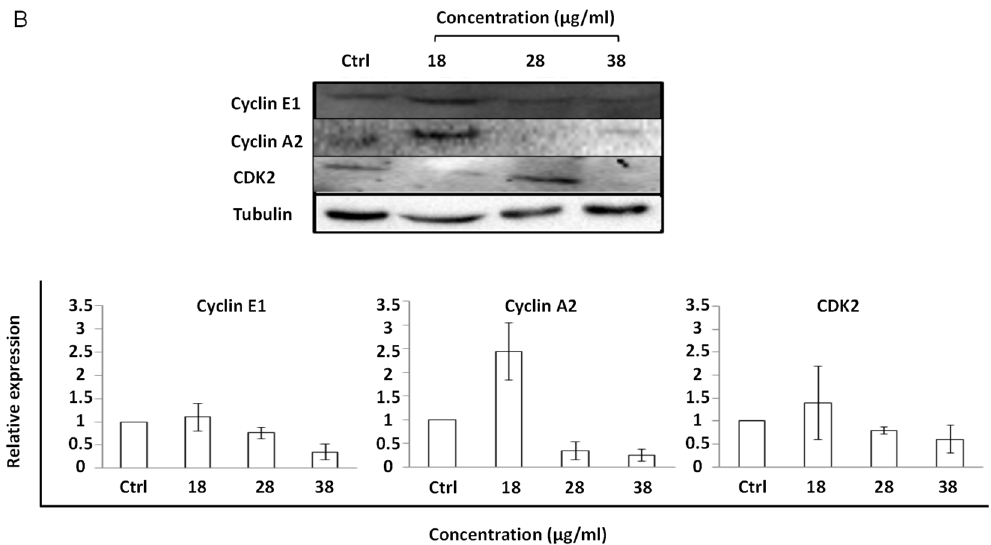
Figure 6. Cell cycle perturbation upon RTEAL treatment is concentration-dependent. ( A ) MCF-7 cells were treated with different concentrations of RTEAL as indicated for 72 h. ( B ) Representative Western blot and the relative protein expression of cyclins and CDK after normalizing with β -tubulin. Data were presented as mean ± SEM from three independent experiments. Asterisks indicate a significant difference (* p < 0.05) for each treatment was compared to the control cells.